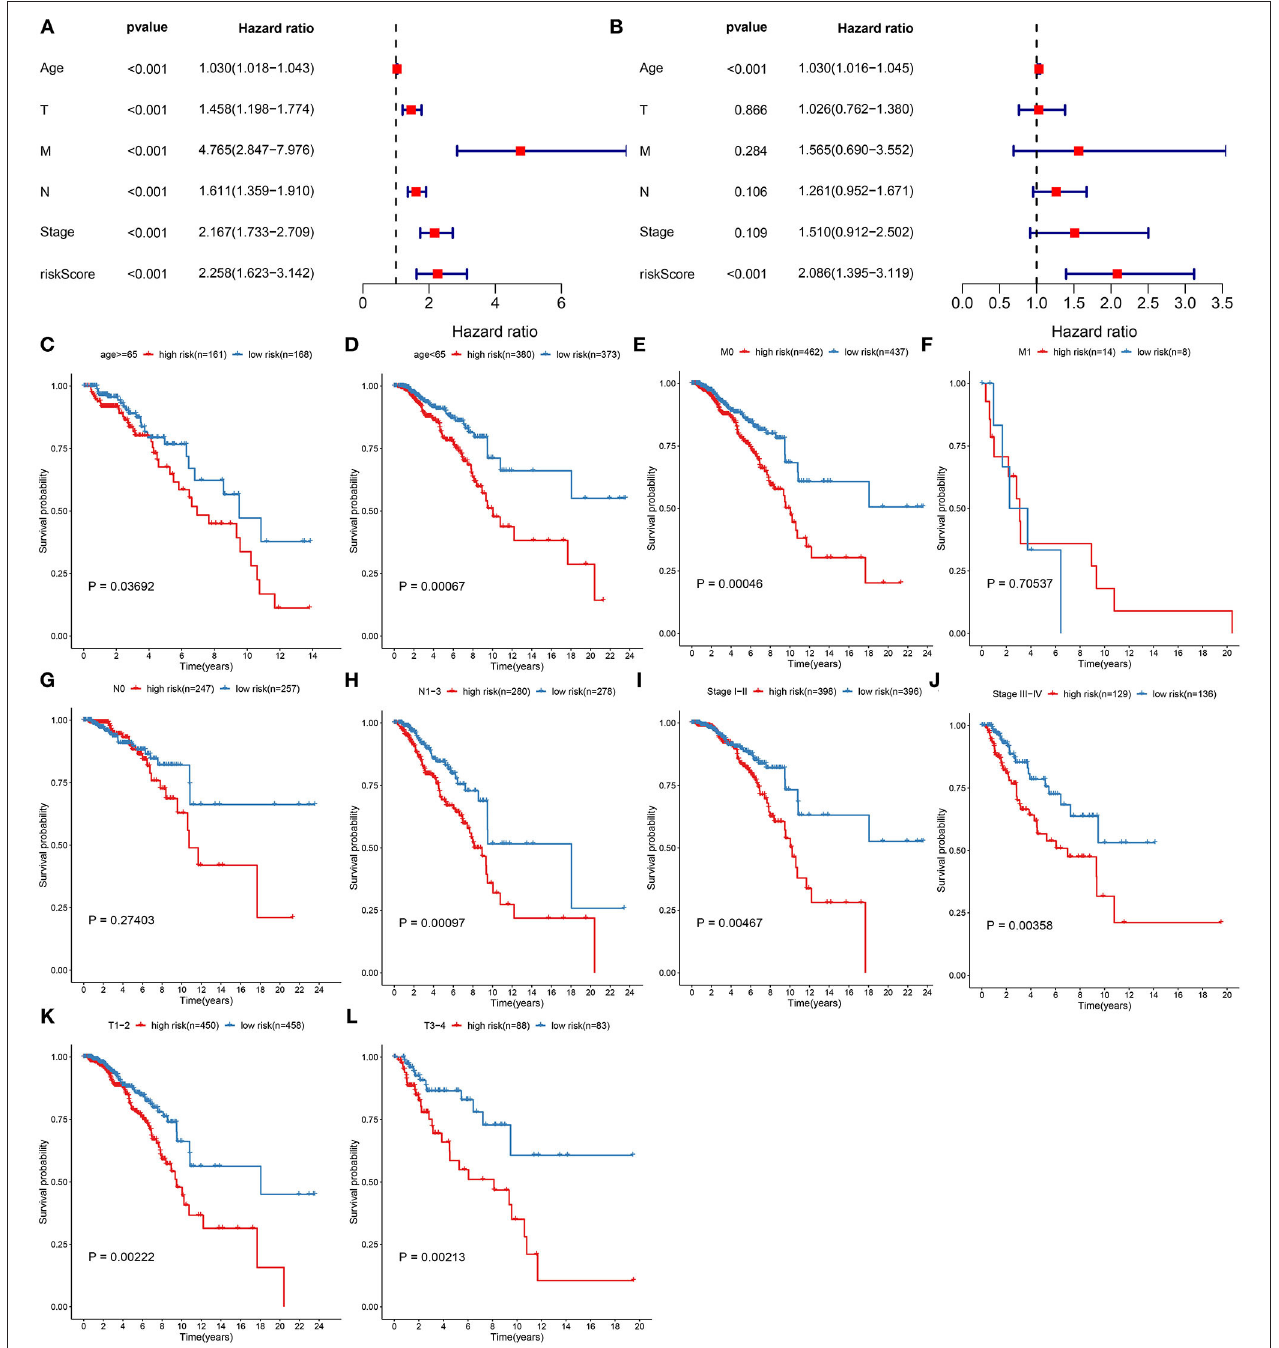
FIGURE 4 | Assessment of predictive independency of the pyroptosis-related gene signature in breast cancer prognoses. (A) Univariate and (B) multivariate analyses for estimating risk scores and age, T, N, M, and stage. Subgroup analysis for investigating the differences in OS probabilities between high- and low-risk samples in (C) age ≥ 65, (D) age < 65, (E) M0, (F) M1, (G) N0, (H) N1-3, (I) stage I-II, (J) stage III-IV, (K) T1-2, (L) T3-4 subgroups.